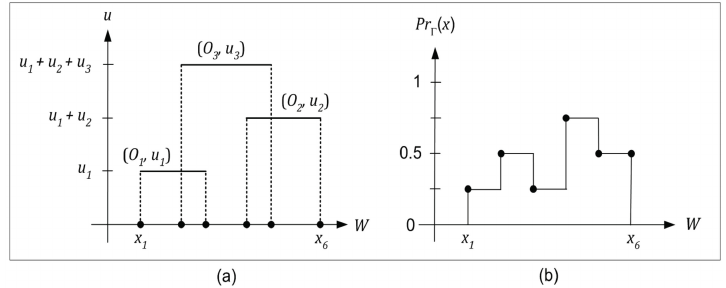
Figure 3. Focal elements with their equal uncertainty assignments u 1 = u 2 = u 3 to construct a realization of random sets ( a ); and covering function of the random sets ( b ). These figures are adapted from Zhao et al.